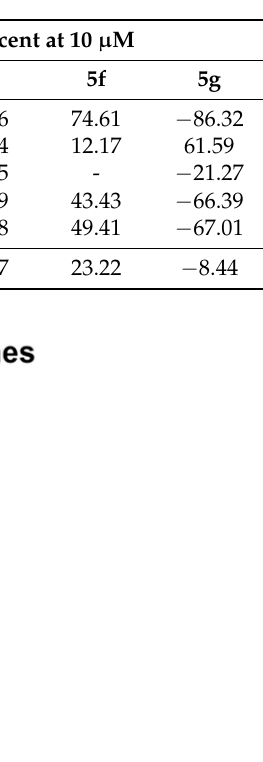
Table 2. In vitro cytotoxicity IC